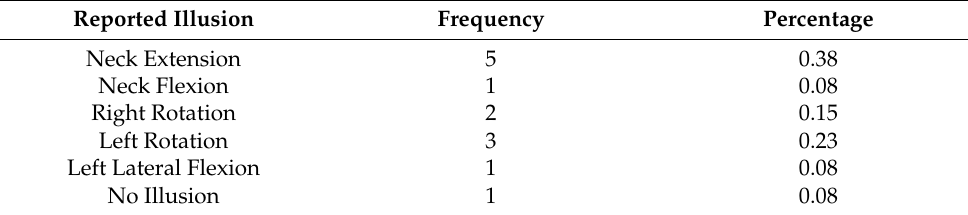
Table 1. Frequency of reported movement illusions in the vibration group.